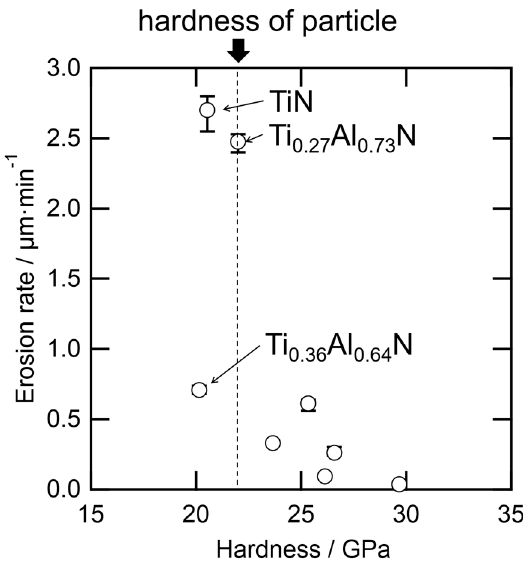
Figure 9. Relationship between hardness and erosion rate of TiAlN coating. There is an abrupt change in erosion rate for hardness at around 20 GPa which is close to the hardness of the alumina particle [29]. For coating (TiN, Ti0.27Al0.73N and Ti0.36Al0.64N) with hardness ( H t ), the erosion rate is lower than the alumina particle hardness ( H p ). The erosion rate is higher for the coatings with H p / H t < 1. For TiN and Ti0.36Al0.64N, cracking and flaking are observed on the eroded surface, which suggests formation of lateral cracking (Figure 8). On the other hand, the surface is relatively smooth, and no sign of cracking can be observed for Ti0.42Al0.58N with H p / H t < 1. These observations agree with the erosion mechanism proposed by Wada [28].